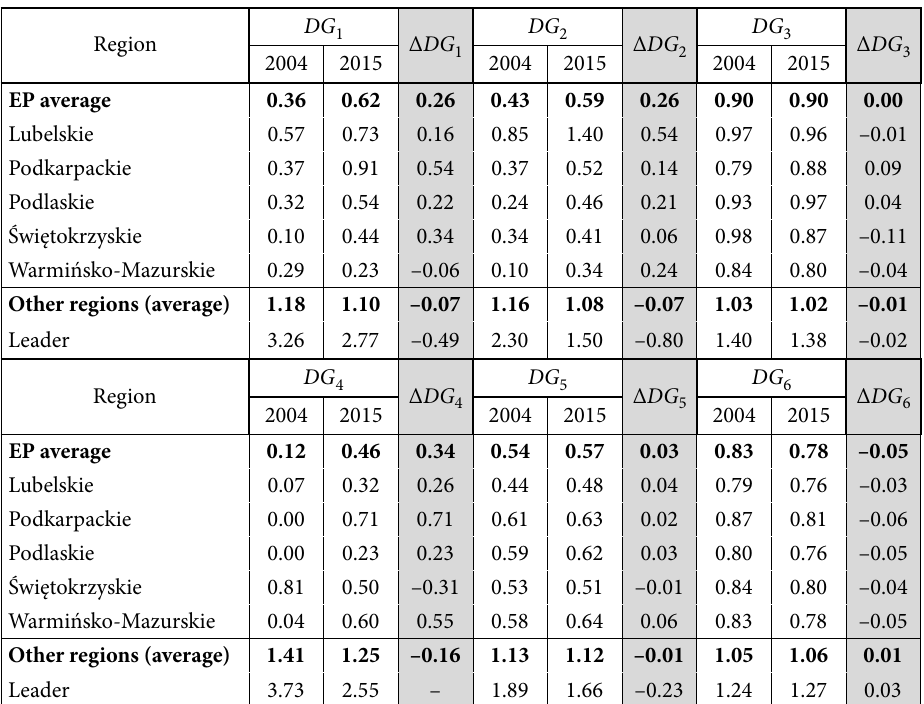
Table 2. Development gaps in 2004–2015 in Eastern Poland regions (source: own calculations based on CSO data) DG Region